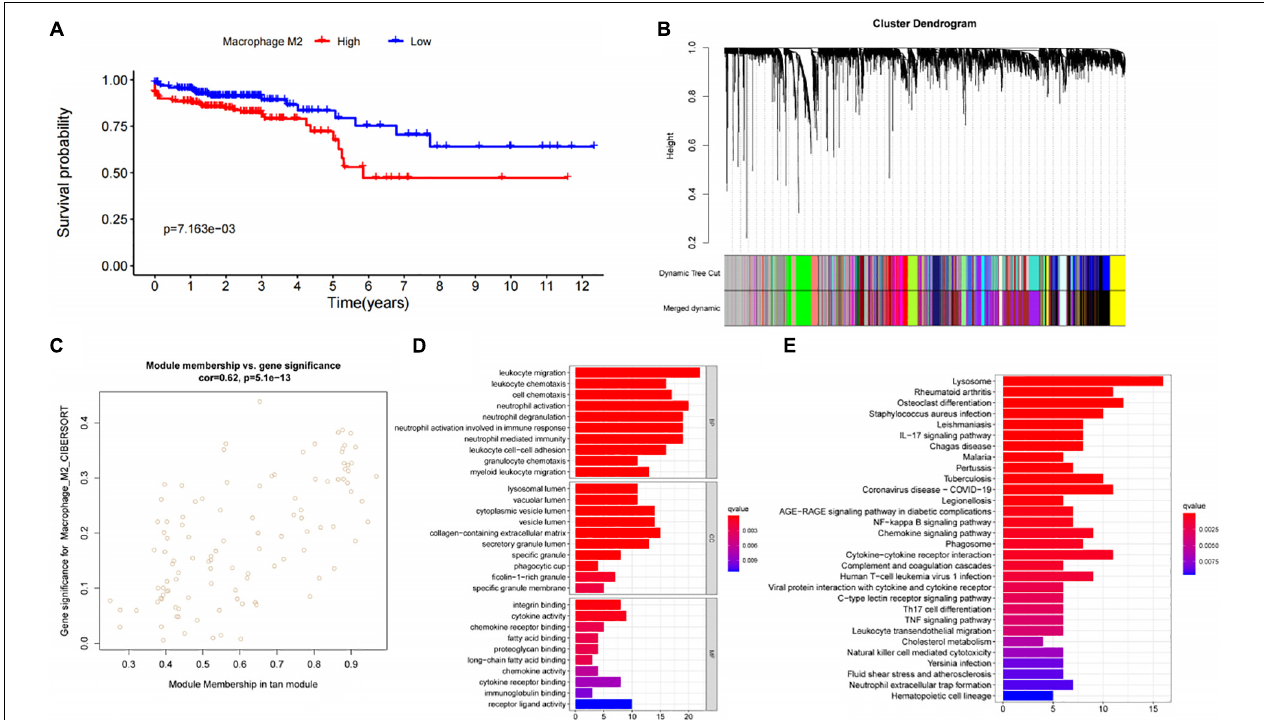
FIGURE 1 | Analysis and screening of M2 macrophage related genes. (A) Survival analysis of patients with different levels of M2 macrophage infiltration. (B) Analysis of gene distribution in WGCNA network. (C) Correlation analysis of Tan module and M2 macrophages. (D) GO analysis of genes in the Tan module. (E) KEGG analysis of genes in the TAN